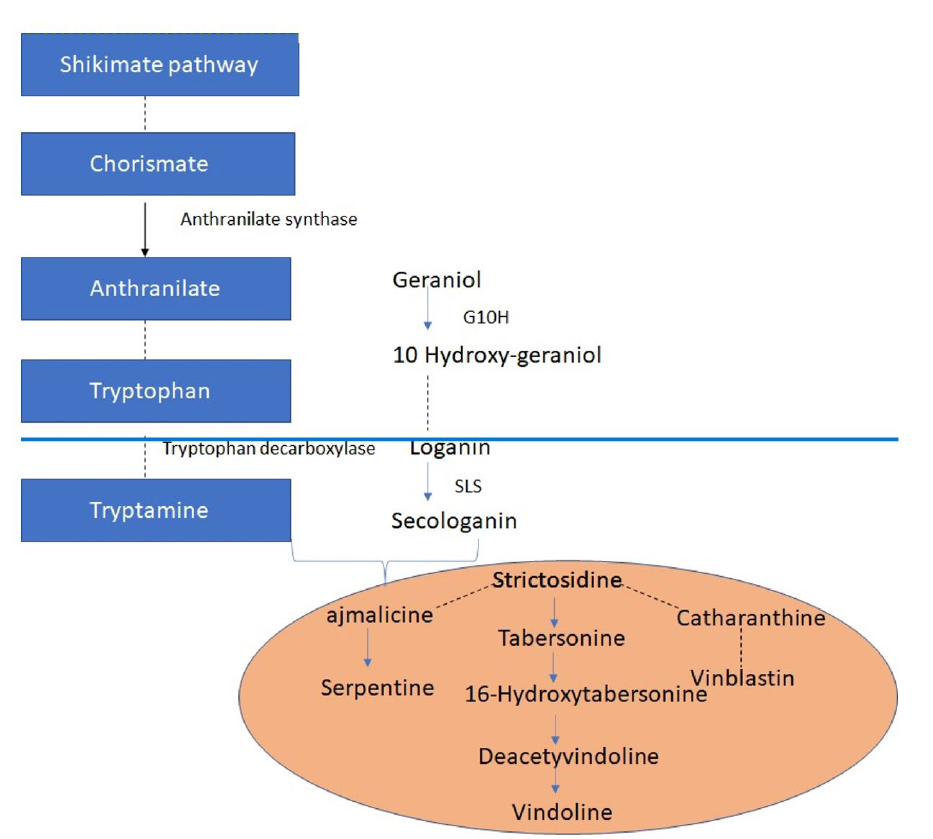
Fig. 1. TIA metabolic pathway in C.roseus . Single enzymatic reactions are indicated by solid arrow, while numerous enzymatic conversions are indicated by dashed arrows